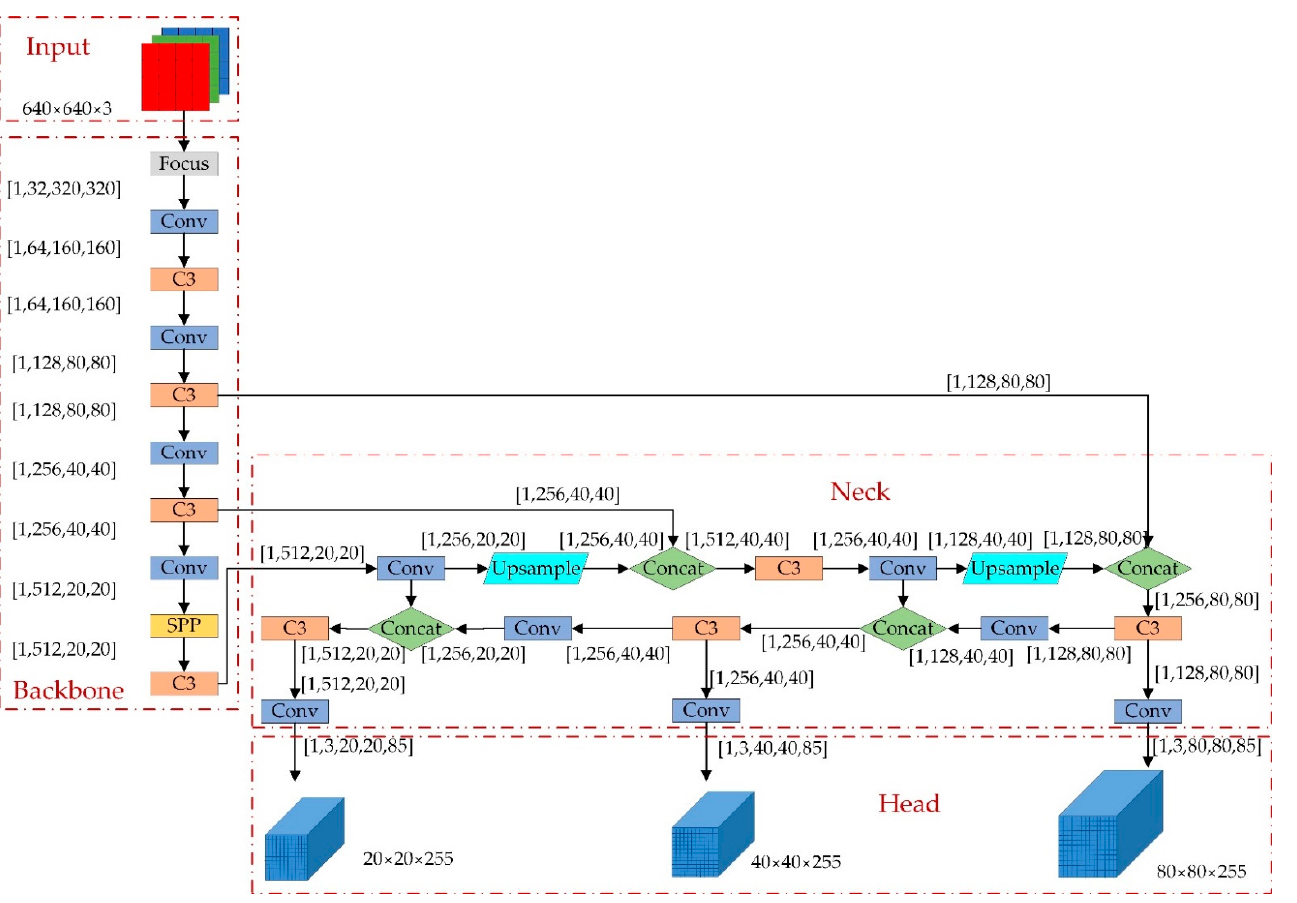
Figure 1. The structure of YOLOv5s.